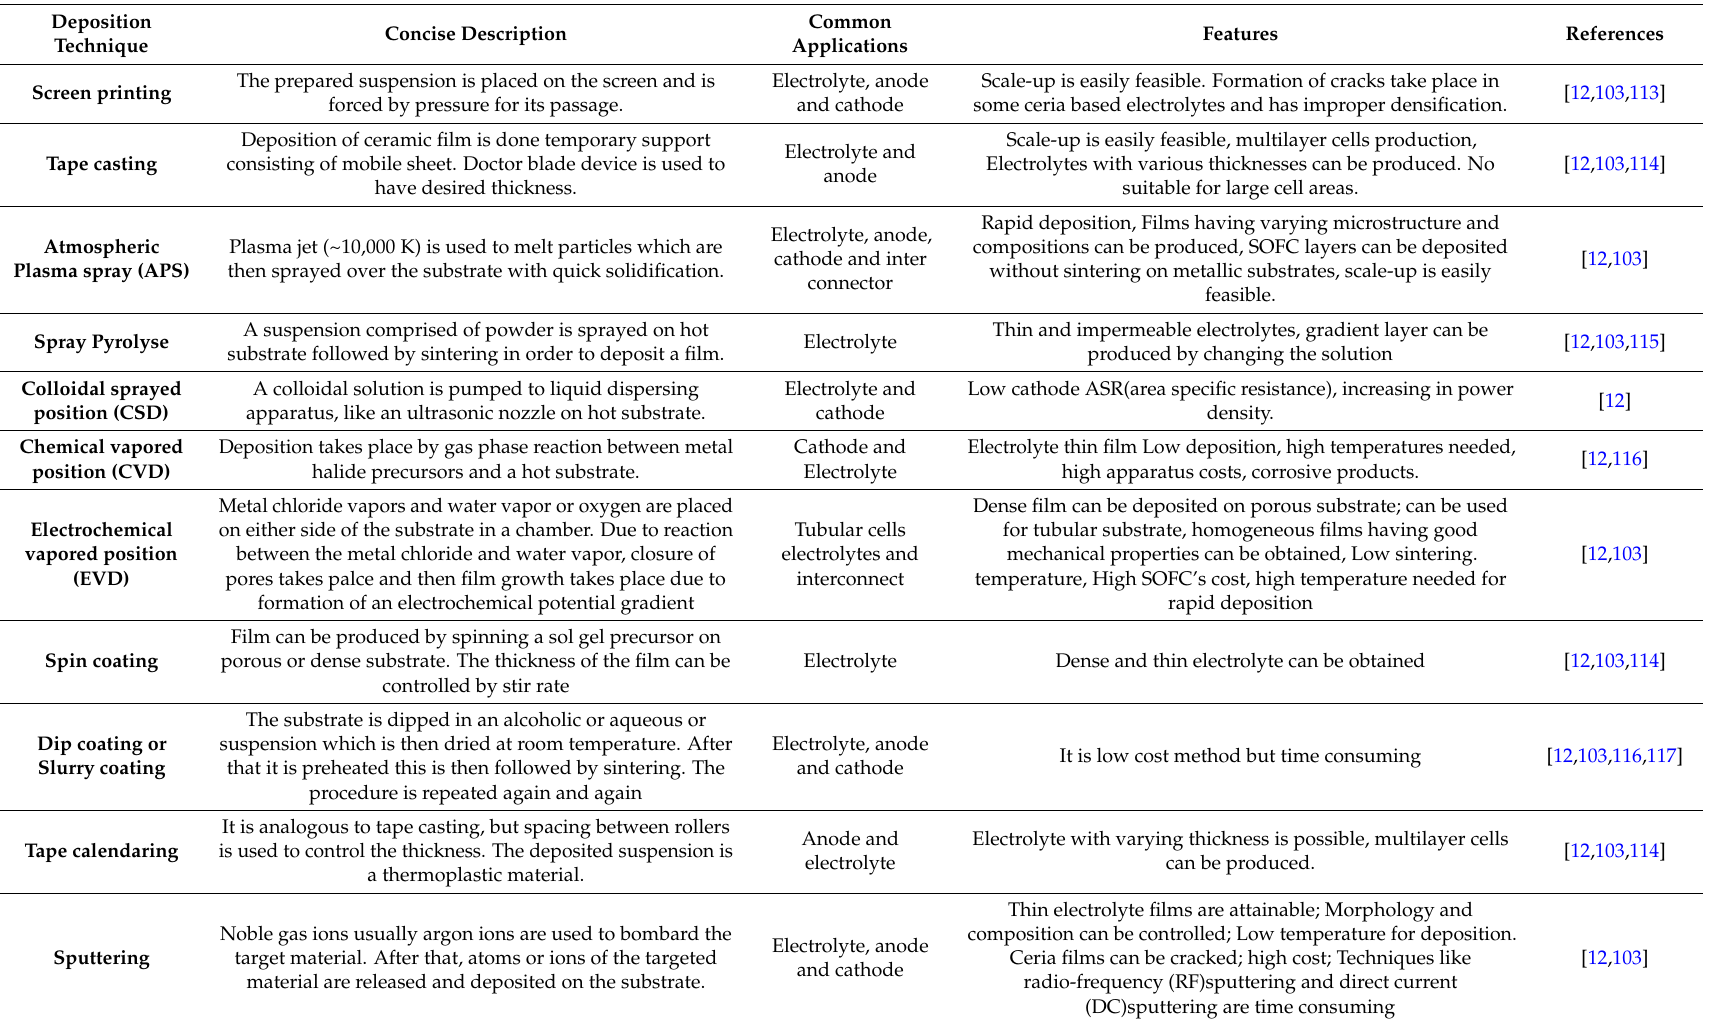
Table 4. A brief description of different deposition techniques